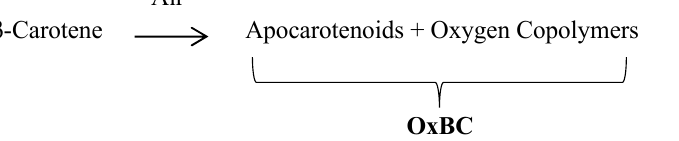
Figure 1. Formation of OxBC by spontaneous oxidation of β -carotene produces mainly a β -carotene oxygen copolymer compound and minor amounts of many apocarotenoid breakdown products.